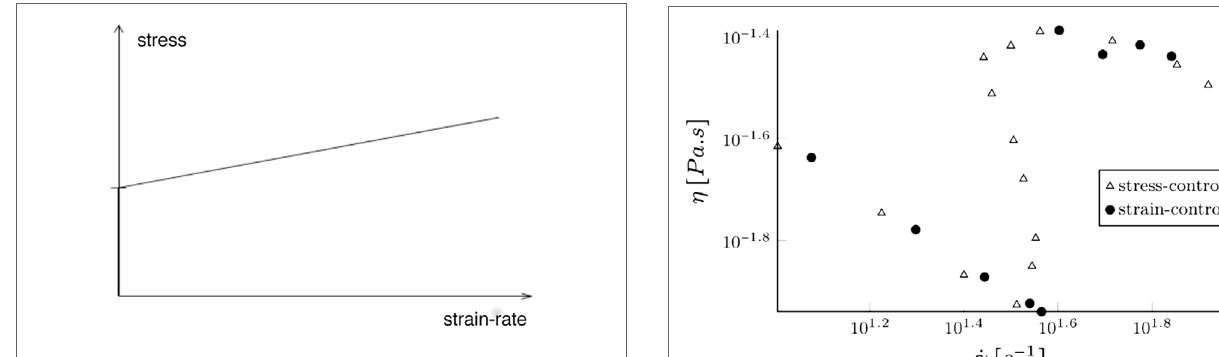
FigURe 2 | The response of a Bingham like mass-dashpot system